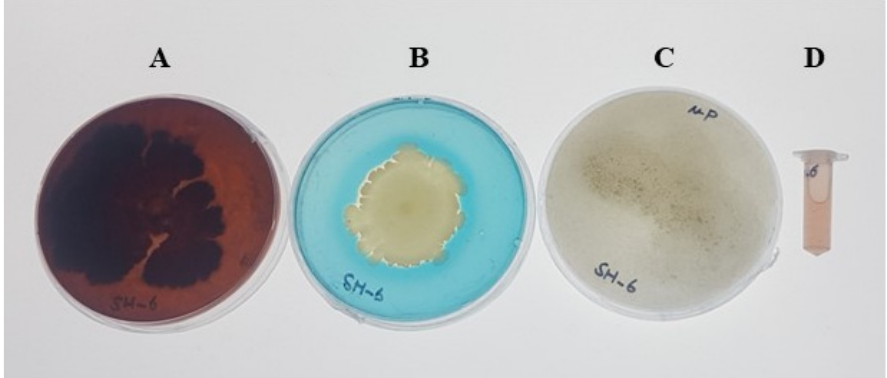
Figure 2. ( A ) Exopolysaccharide, ( B ) phosphate solubilization, ( C ) siderophore production, and ( D ) IAA production by the new rhizosphere bacterial isolate SH-6.